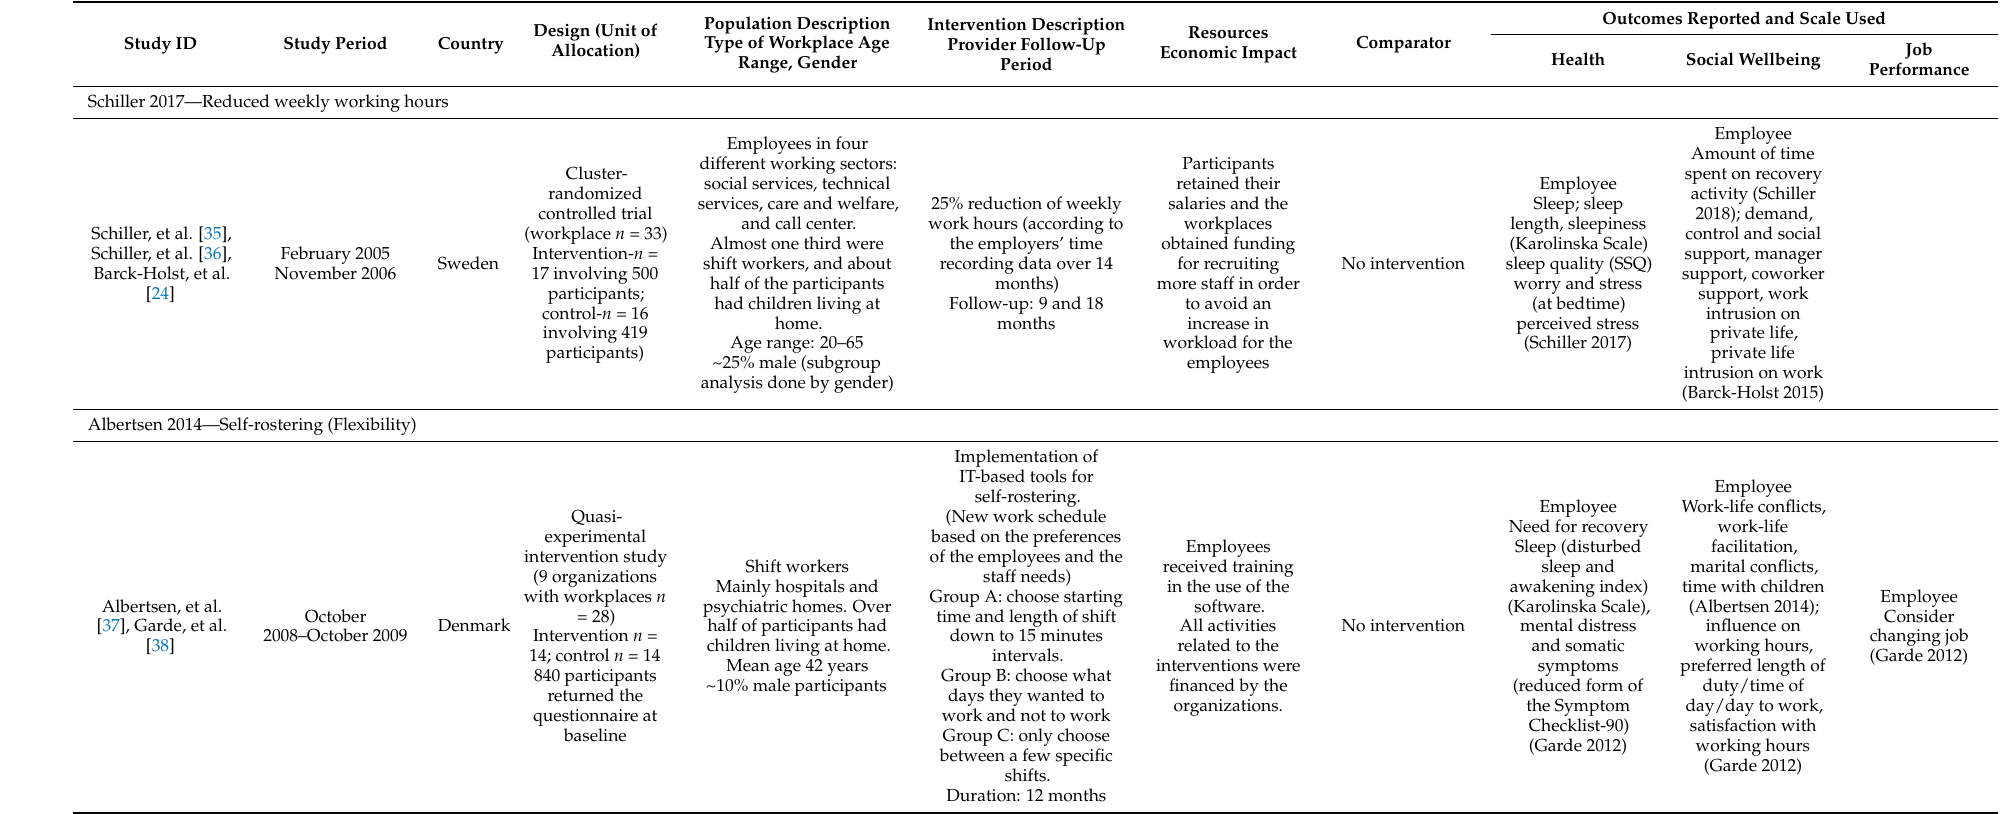
Table 1. Characteristics of included